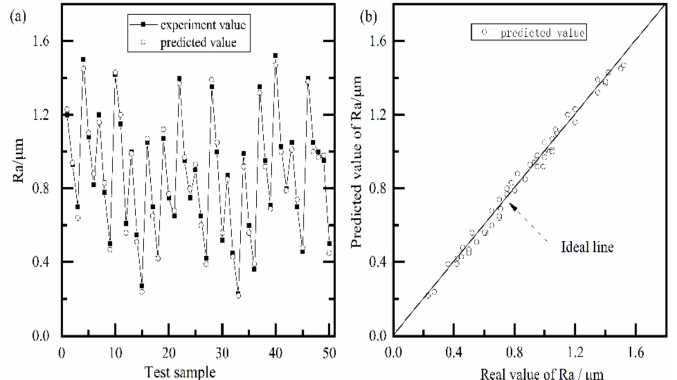
Figure 9. Testing result ( a ) and regression plot of predicted value and experiment value ( b